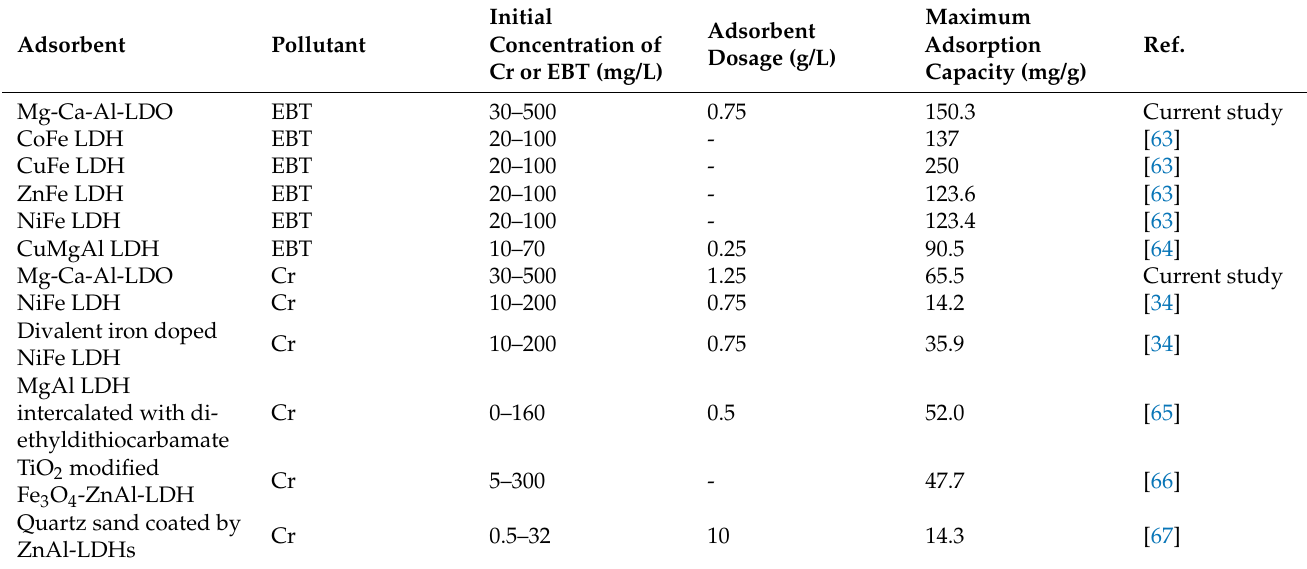
Table 5. Summary of the maximum adsorption capacity of selected LDH materials toward EBT and Cr ions from water.